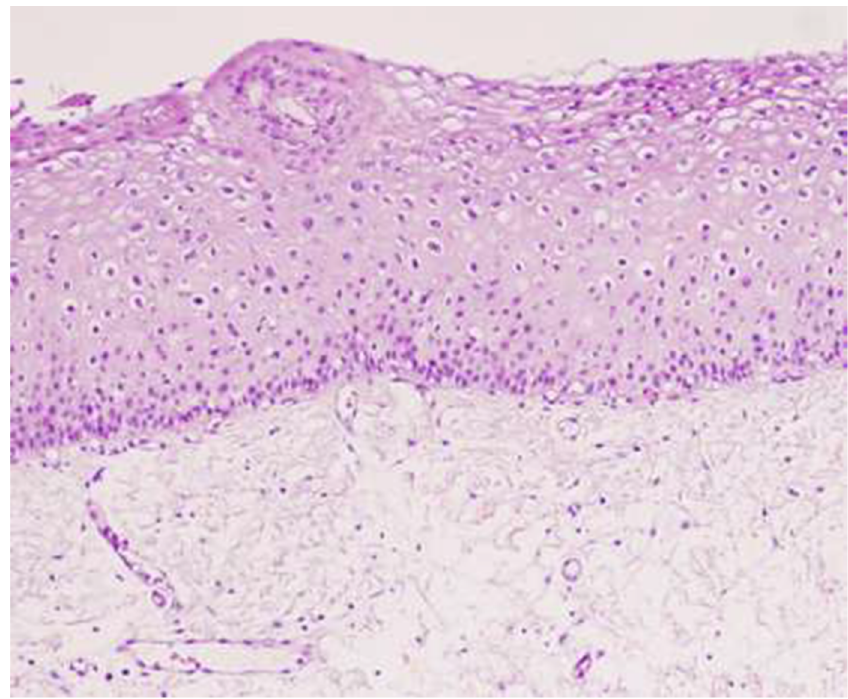
Figure 3. Low-grade squamous intraepithelial lesion (LSIL), 40×. Courtesy of Dr. Mauricio Iribarren, General Surgery Department, Álvaro Cunqueiro Hospital, Vigo.